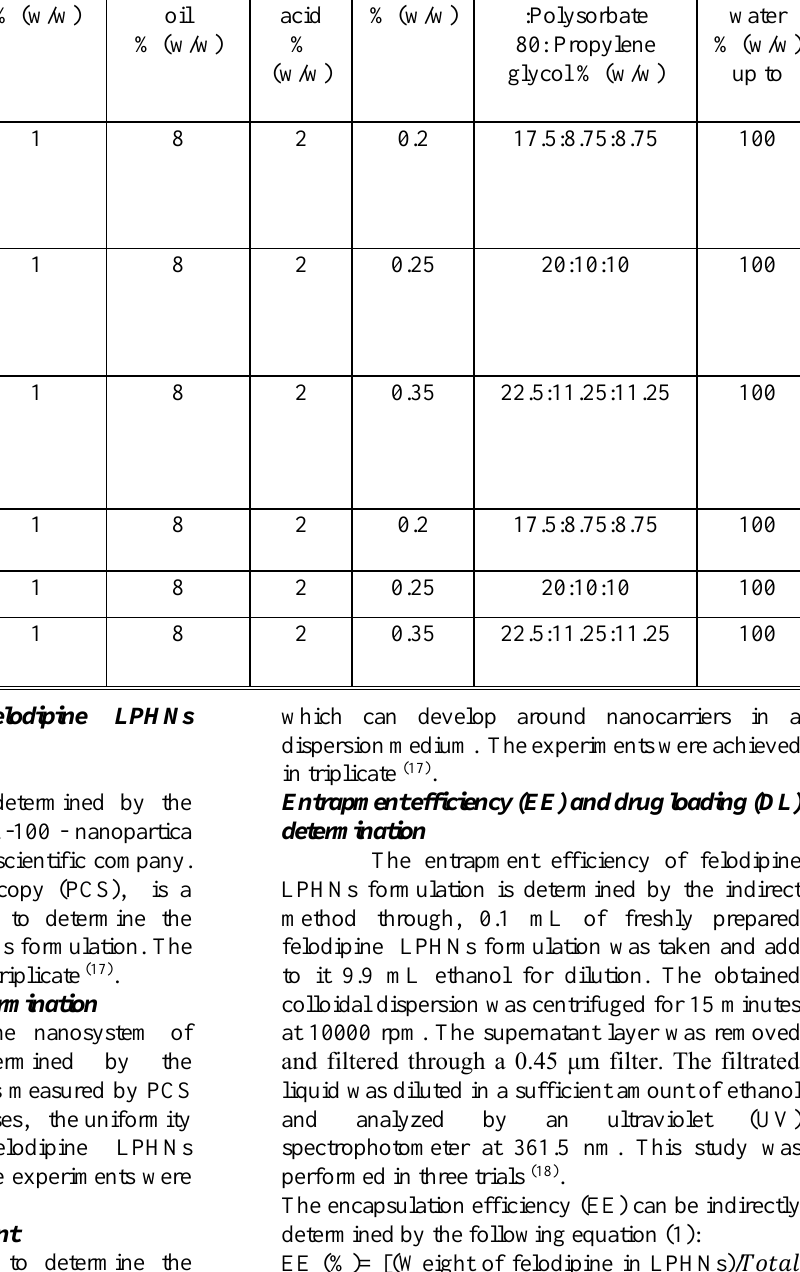
Table 1. The selected felodipine LPHNs formulations (HF1-HF6) for characterization and optimization.